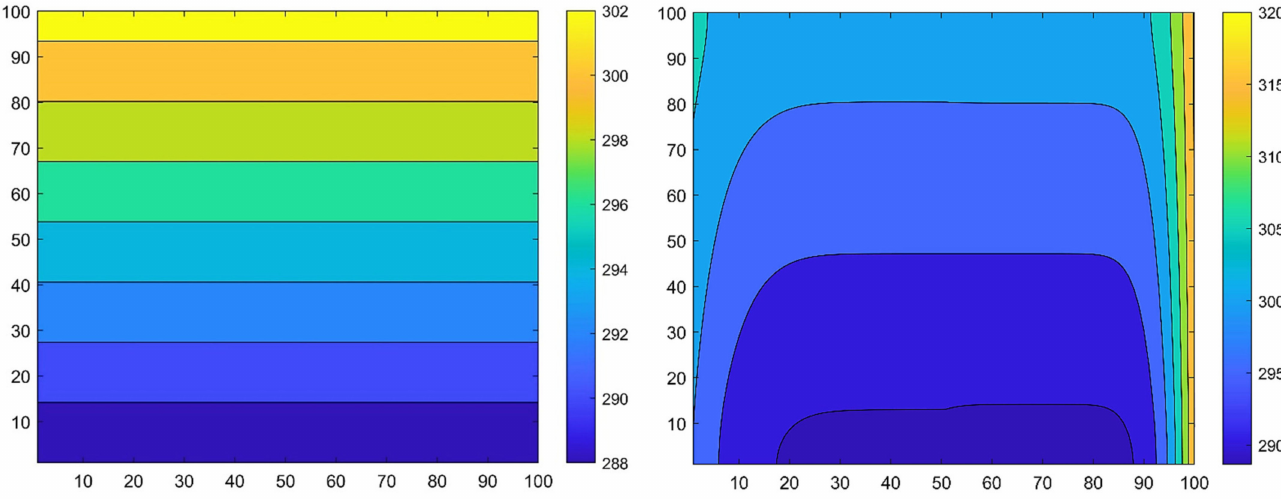
Figure 12. The temperature distribution contour in Kelvin for the equidistant mesh at initial ( left ) and final time ( right ) in the case of the multilayer cross-sectional area. The numbers on the vertical and horizontal axes of the contours are the indices of the cells.